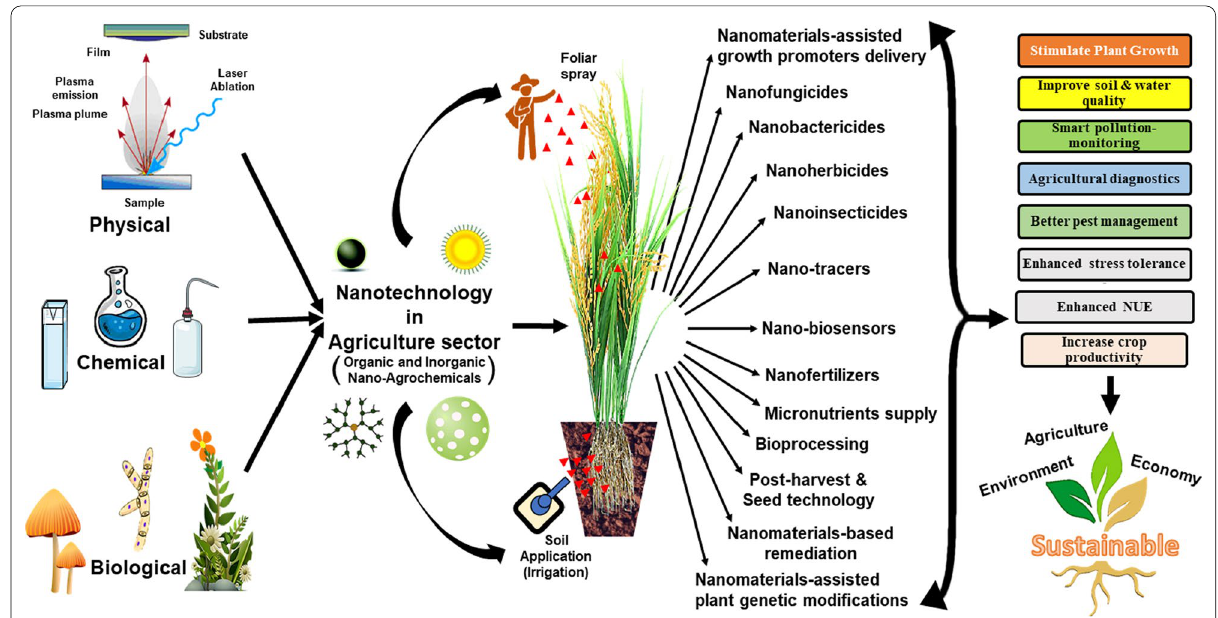
Fig. 3 Various applications of nanotechnology in the agriculture